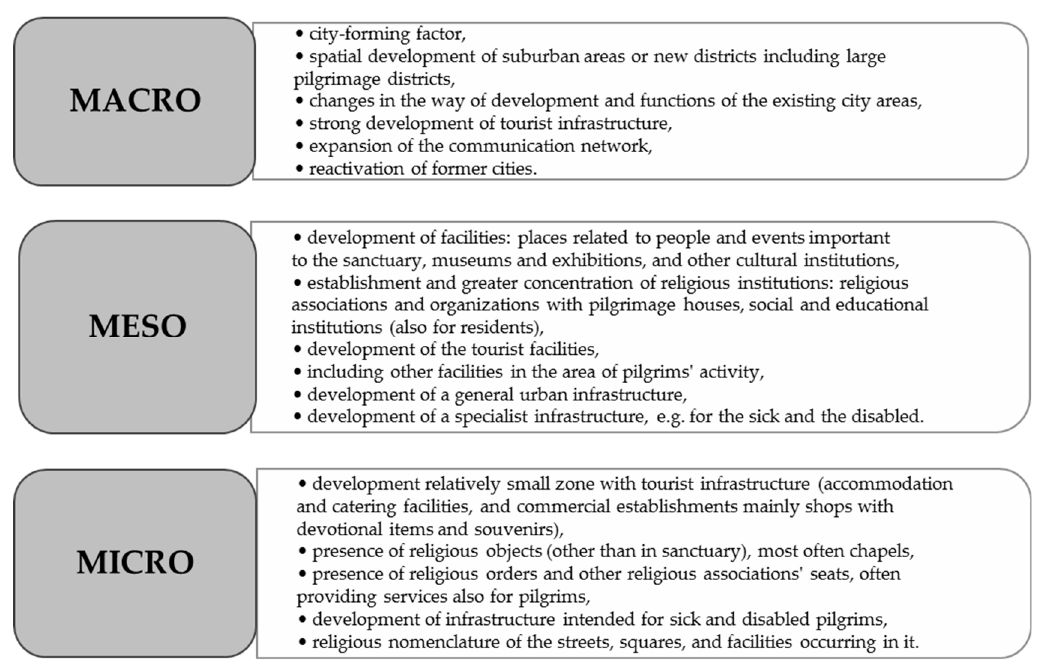
Figure 2. The spatial scales of pilgrimage centers and religious tourism’s impact on the city space.